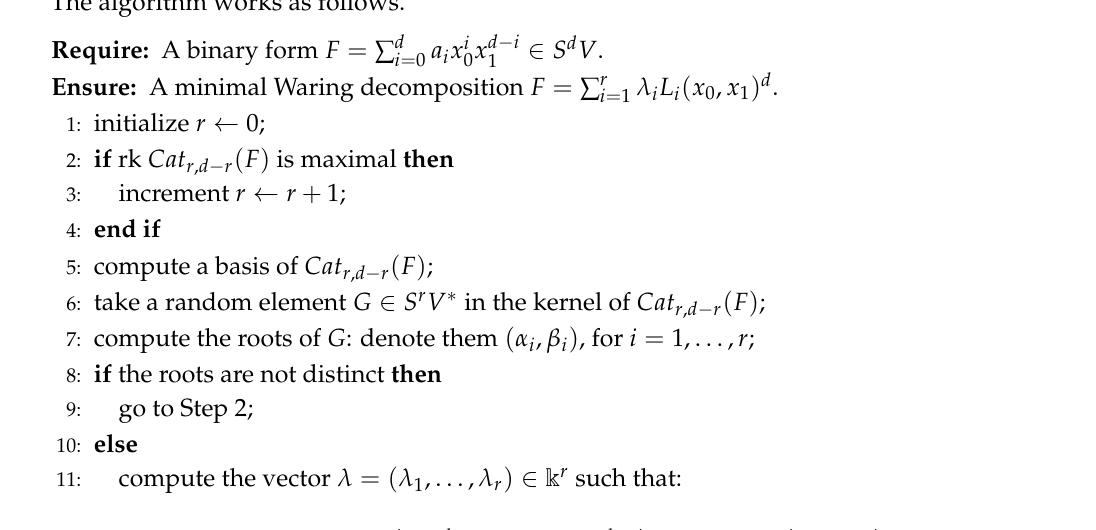
Algorithm 1: Sylvester’s